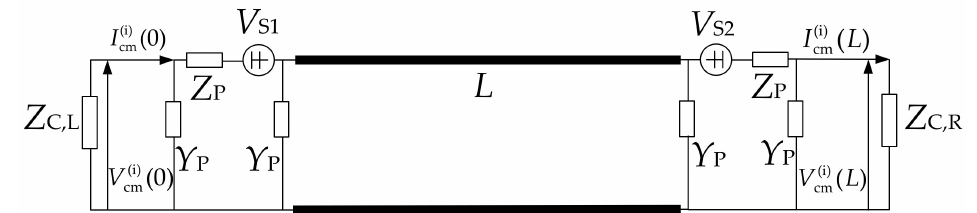
Figure 2. CM circuit in injection